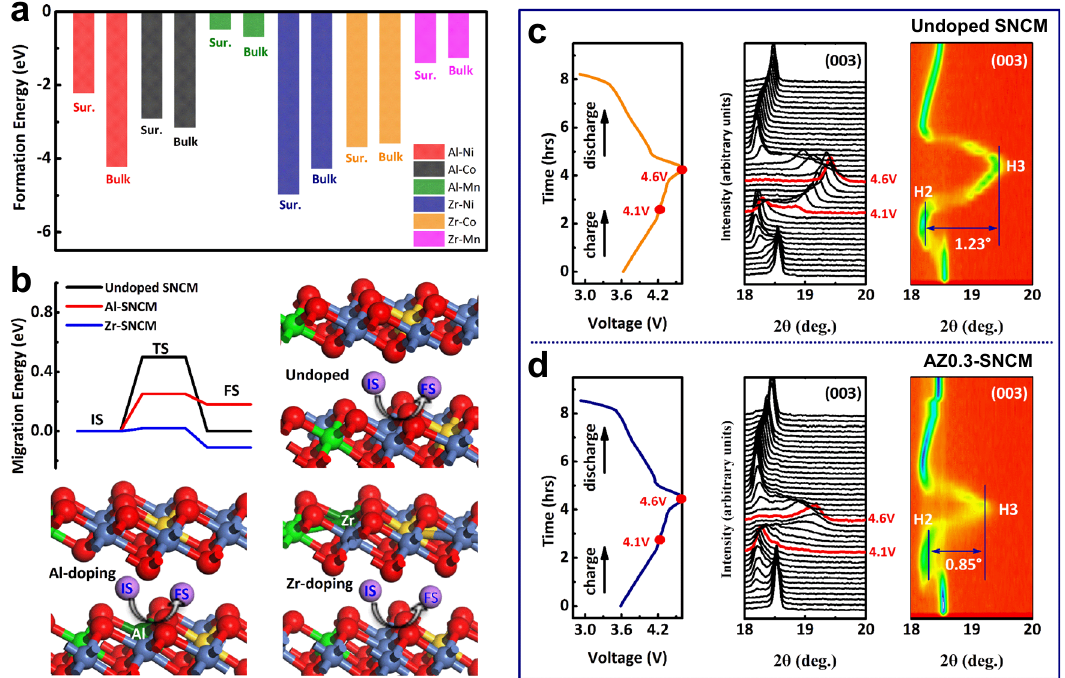
Fig. 4 Density theory calculation and in situ XRD characterization during charge/discharge process. a Formation energy for replacing Ni, Co, or Mn ions both surface (Sur.) and bulk layer (Bulk) with Al or Zr ions. b Migration energy and corresponding schematic structure for undoped SNCM, Al or Zr doped SNCM (Al-SNCM and Zr-SNCM): IS, TS and FS represent initial state, transition state, and fi nal state, respectively. In situ XRD characterizations of undoped SNCM ( c ) and AZ0.3-SNCM ( d ) during the initial charge – discharge cycle. In situ XRD measurement was conducted on an in-house developed cell with Li metal and 1 M LiPF 6 in EC/DEC (1:1 in volume) as counter electrode and electrolyte at 25